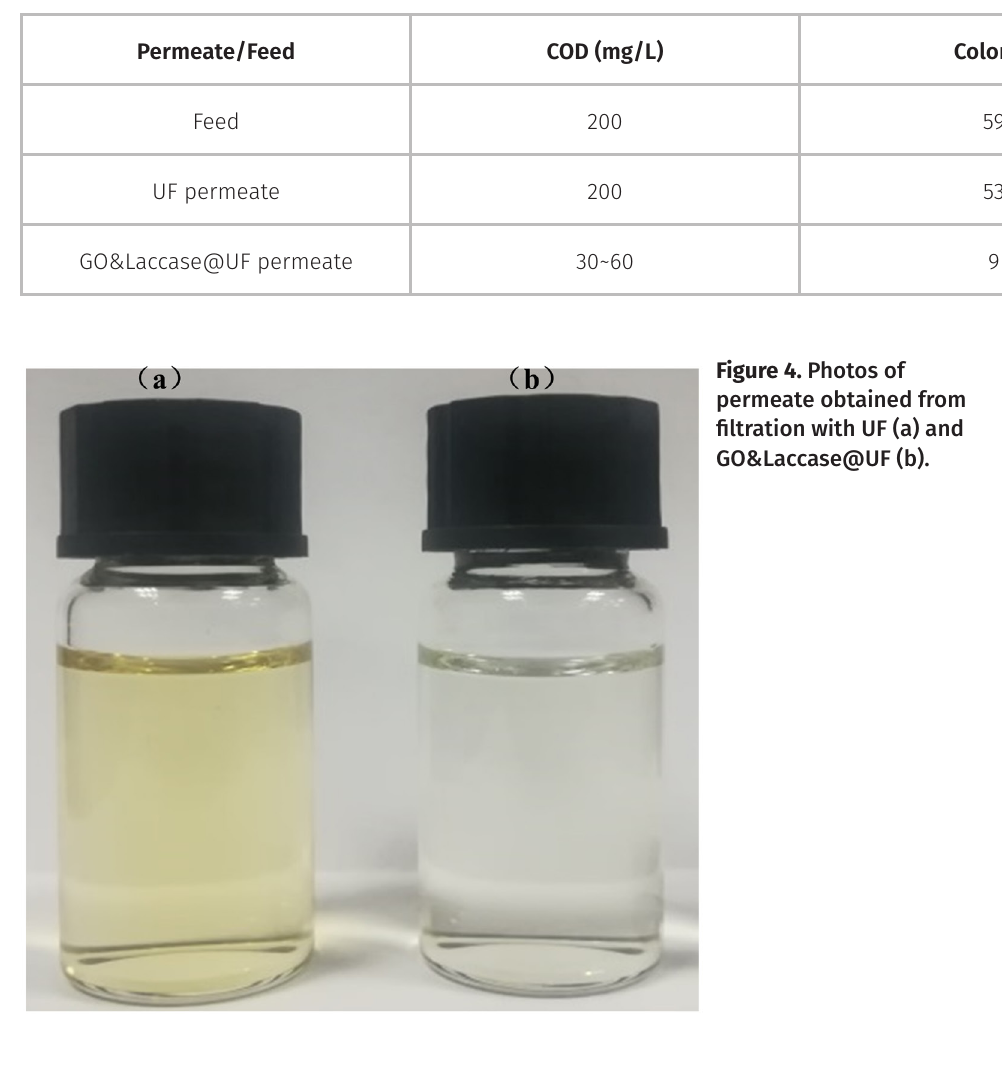
Table I. COD and colority of permeate obtained from different